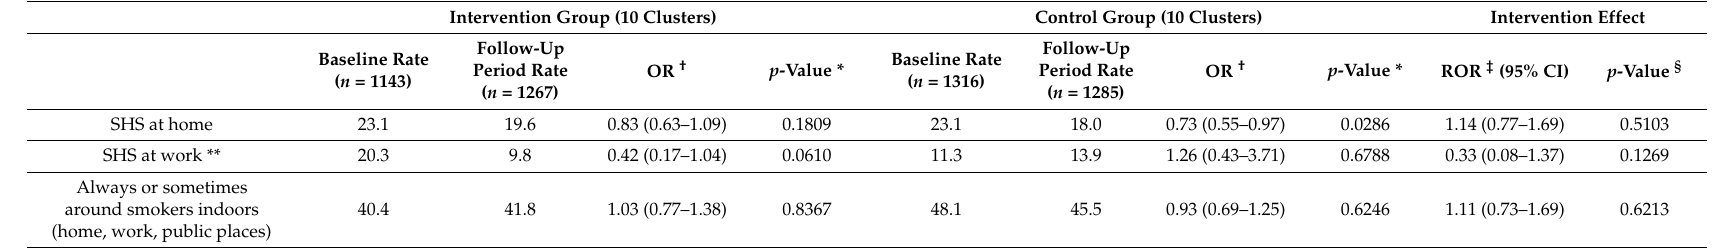
Table 1. Effect of intervention on secondhand smoke exposure on non-smokers and quitters globally.